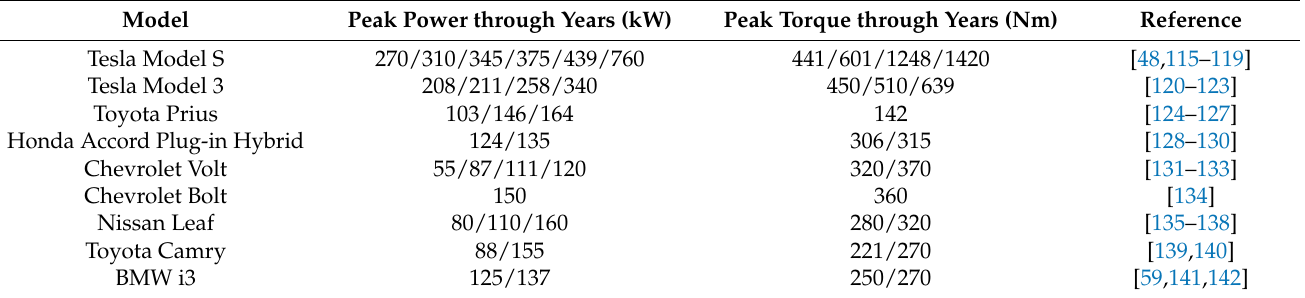
Table 4. Motors specifications through the